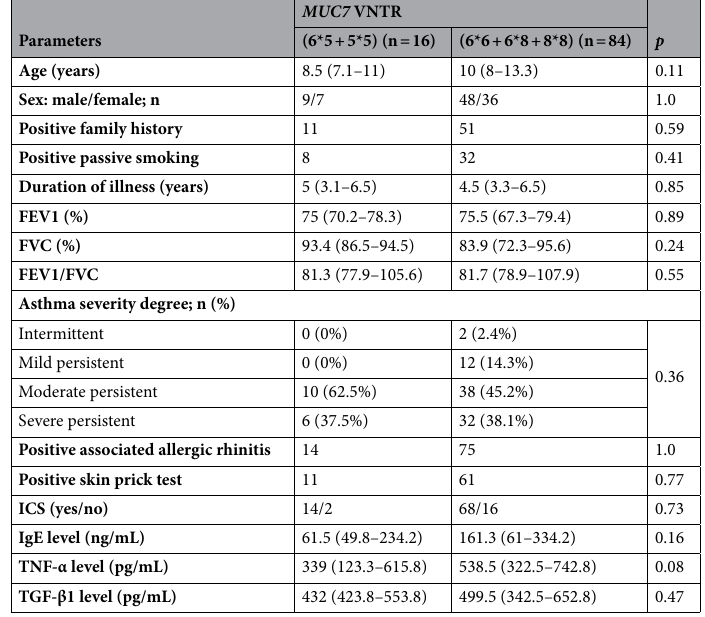
Table 4. Associations of MUC7 VNTR genotypes with demographic, clinical features, and biochemical measurements in asthmatic patients. Data are presented as numbers with percentages or median with interquartile range. Chi square and Mann–Whitney U tests were applied. FEV1 forced expiratory volume, FVC forced vital capacity, ICS inhaled corticosteroids, IgE immunoglobulin E, TNF-α tumor necrosis